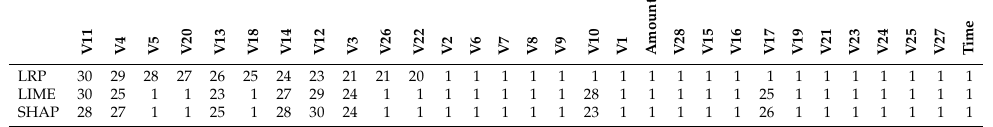
Table 6. Ranked feature comparison for LRP, SHAP, and LIME over the credit card